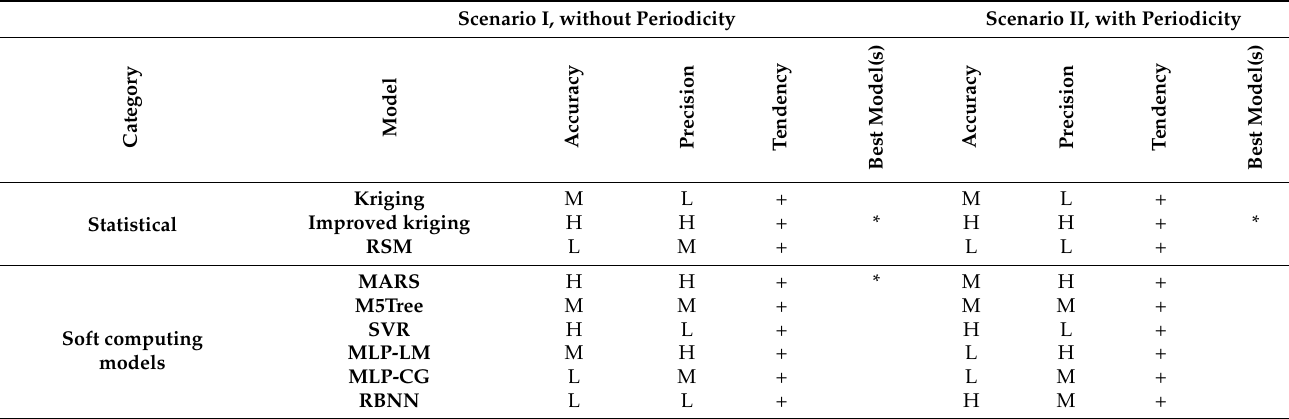
Table 3. The general performance of the applied models in terms of accuracy, precision, and tendency for Adana Station in the testing